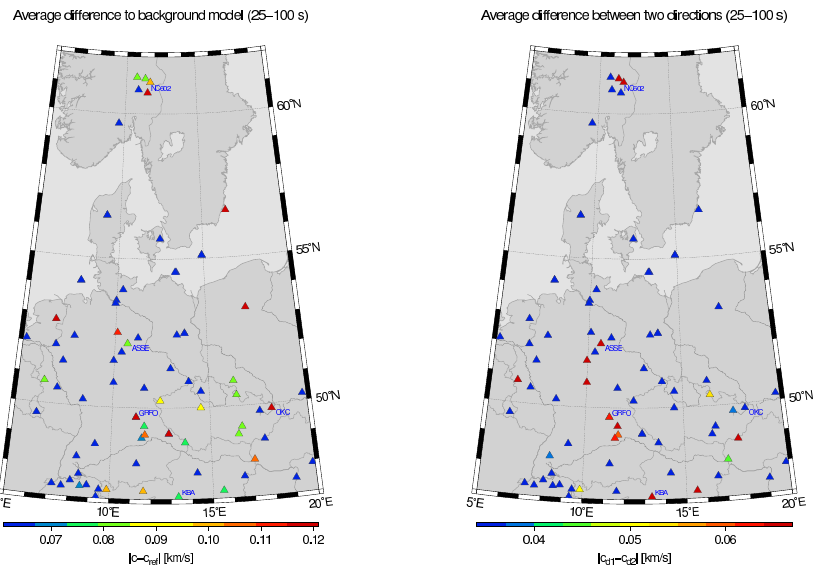
Fig. 3. Averaged deviations of measured dispersion curves in the period range 25–100s (left) from the reference model and (right) between the two propagation directions. Stations with large standard deviations point to data inconsitencies which need to be manually checked. Stations with insignificant number of measurements are omitted.